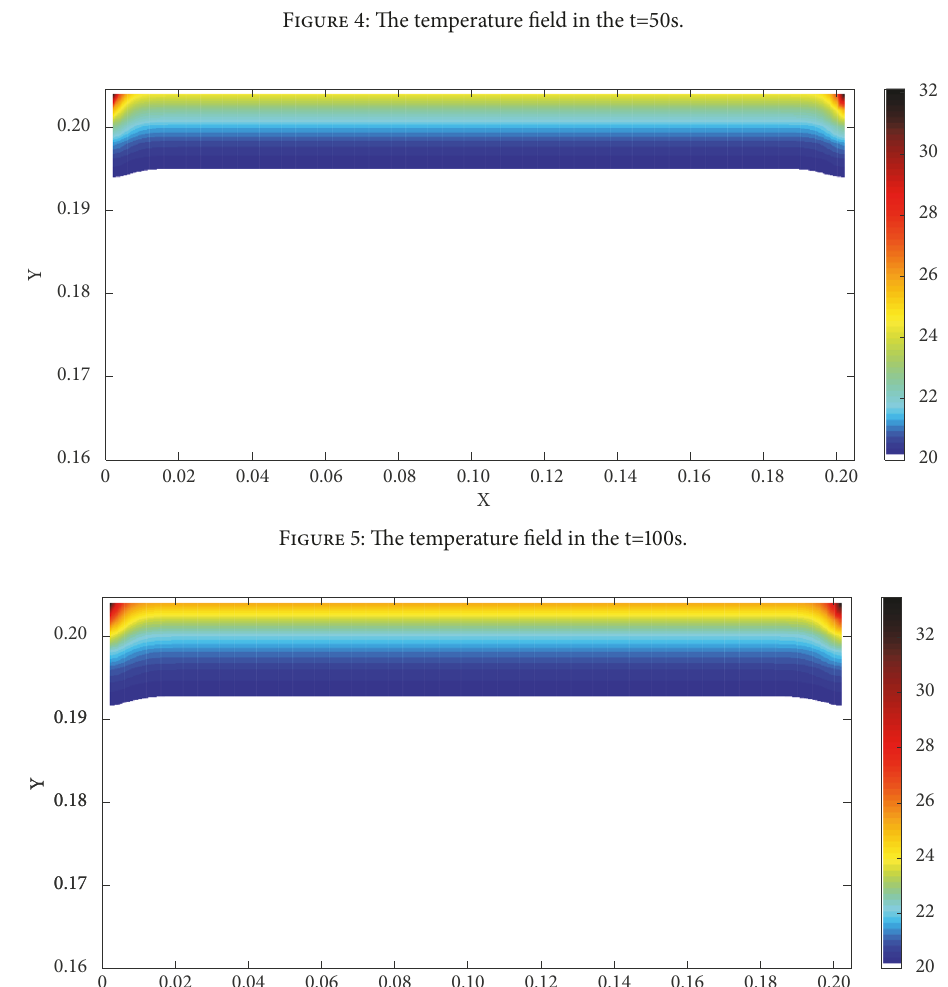
Figure 4: The temperature field in the t=50s.